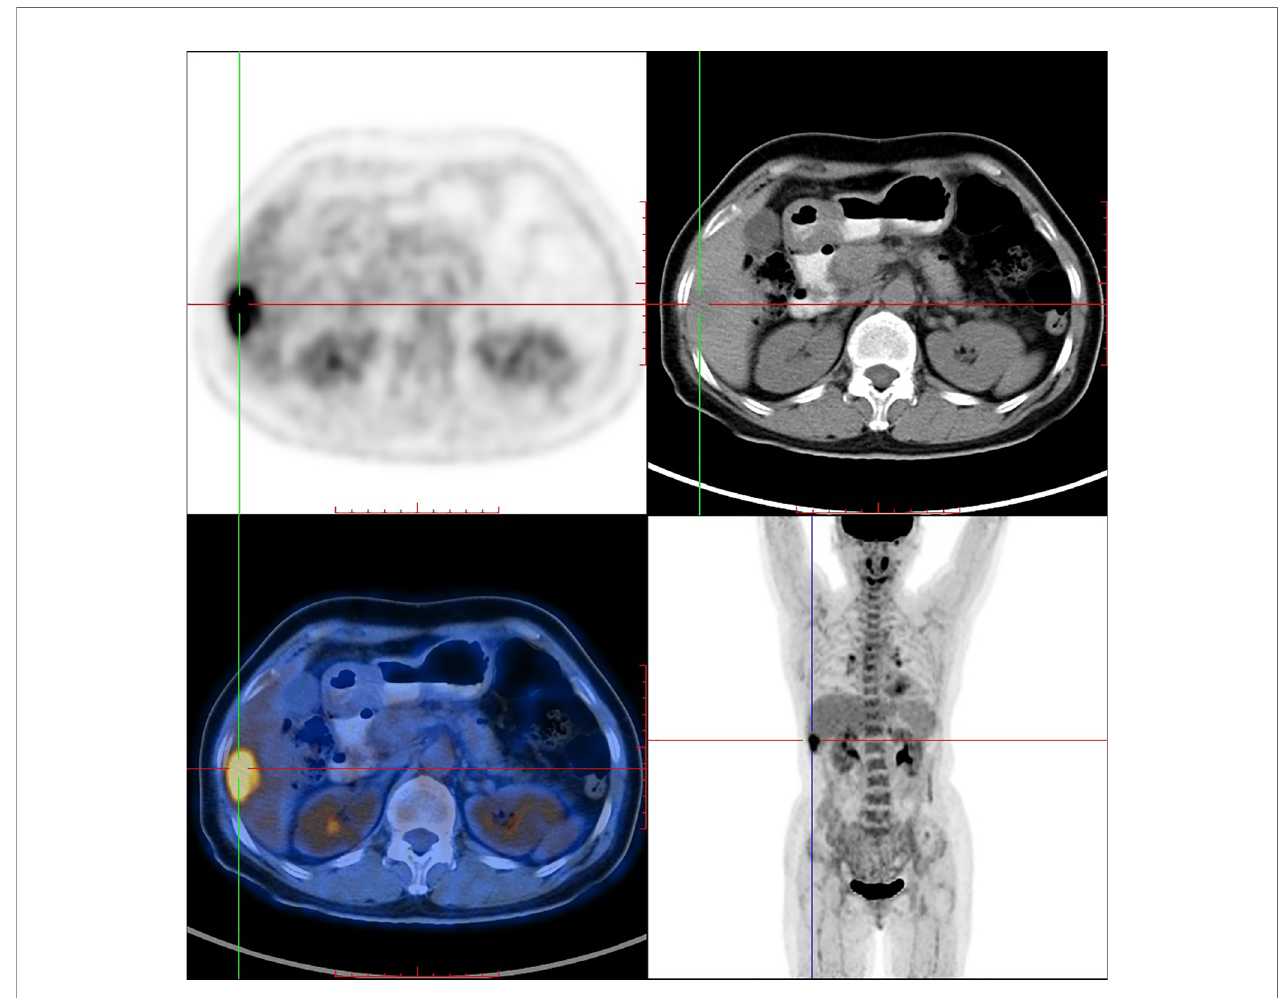
FIGURE 6 | 18 F-FDG PET/CT imaging of the same female IDC patient (54